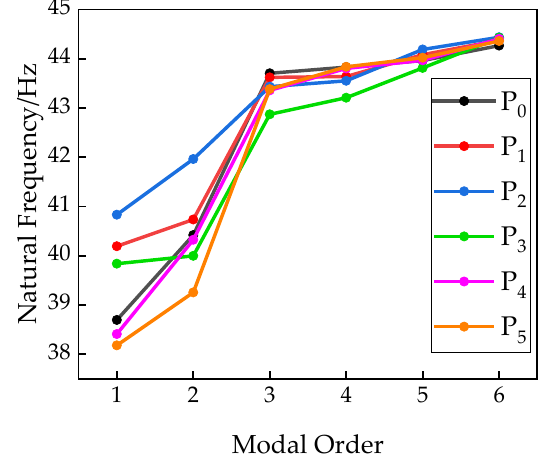
Figure 4. Physical quantity of the Delta robot under the motion trajectory: ( a ) position curve of the robot in the Cartesian space; ( b ) velocity curve of the robot in the Cartesian space; ( c ) acceleration curve of the robot in the Cartesian space; ( d ) angle curve of the robot in the joint space; ( e ) angular velocity curve of the robot in the joint space; ( f ) angular acceleration curve of the robot in the joint space.